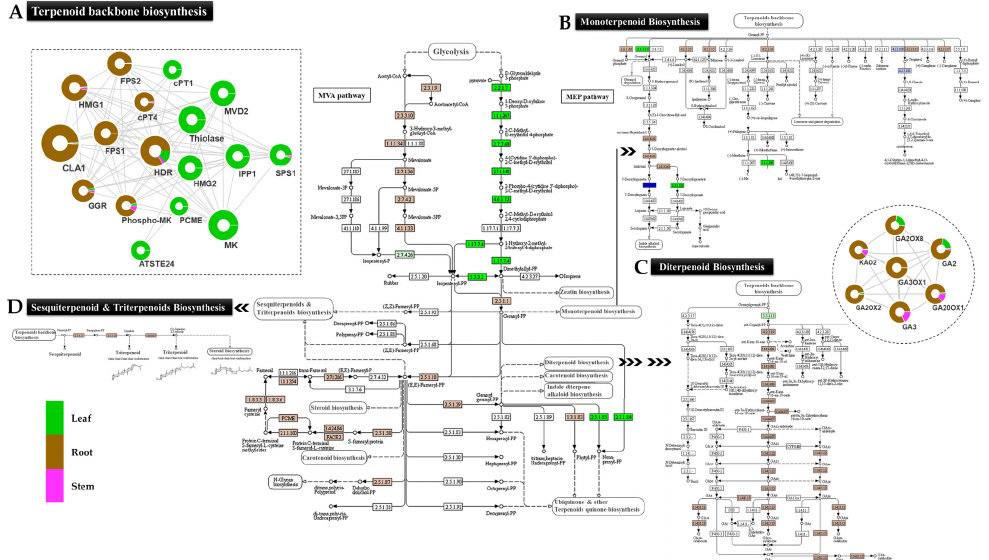
Figure 6. Integrated predicted network with spatially enriched sesquiterpenoid, monoterpenoid, and diterpenoid biosynthesis pathways, comprising unigenes corresponding to ( A ) terpenoid biosynthesis, ( B ) CYP450 family corresponding to monoterpenoid biosynthesis and ( C ) diterpenoid, ( D ) sesquiterpenoid, and triterpenoid biosynthesis in Inula racemsa . Interestingly, the unigene having close homology with Germacrene-A-oxidase (DN54862_c0_g1), Germacrene 8 hydroxylase (DN1910_c0_g1) belonging to CYP450 su- perfamily, and Germacrene A synthase (DN3103_c0_g1) involved in the sesquiterpenoid